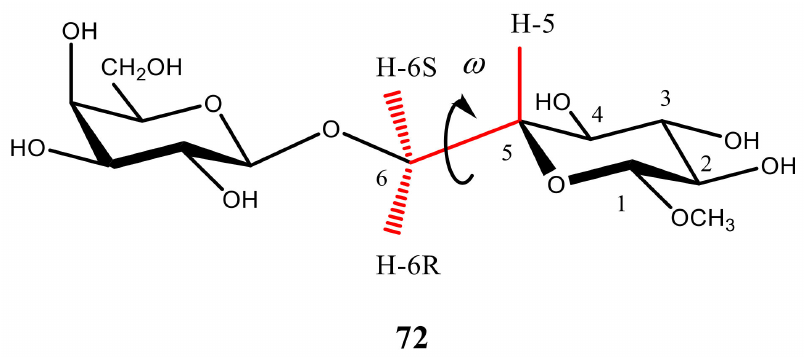
Figure 37. A representative structure of methyl β -D-galactopyranosyl-(1 → 6)- β -D-glucopyranoside used for the investigation of the Karplus dependence of 2 J (H-6 R ,H-6 S ), 3 J (H-5,H-6 R ), and 3 J (H-5,H-6 S ). Zhang et al. [149] tried to find the evidence of the intramolecular hydrogen bonding involving the hydroxyl group at the C 3 and O atoms of the adjacent pyranosyl ring in the experimental and the B3LYP computed values of the inter-ring 3h J coupling constant, C-4 (cid:48) ,H as exemplified below for methyl α -lactoside methyl β -D-galactopyranosyl-(1 → 4)- α -D- glucopyranoside ( 73 ). However, computed values of 3h J in 73 (Figure 38) and related C-4 (cid:48) ,H structures appeared to be next to negligible (ca. 0.1 Hz), and no presence of that coupling was observed experimentally.